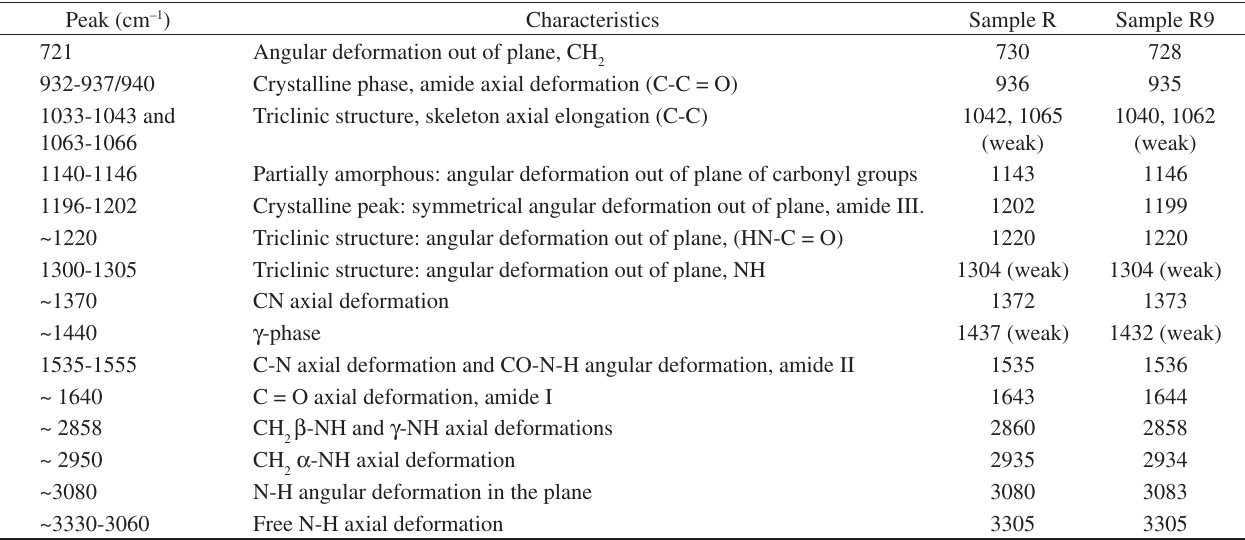
Table 9. Main FTIR peaks observed in samples R and R9. Peak (cm –1